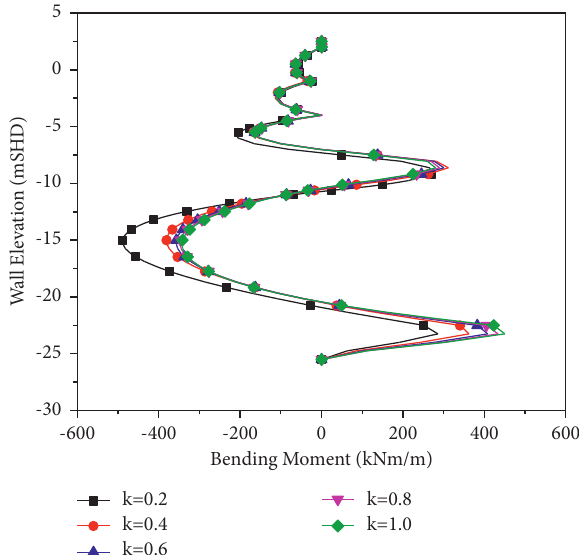
Figure 6: The relations between pre-augering loosening effect and wall bending moment at the excavation to the FEL stage.